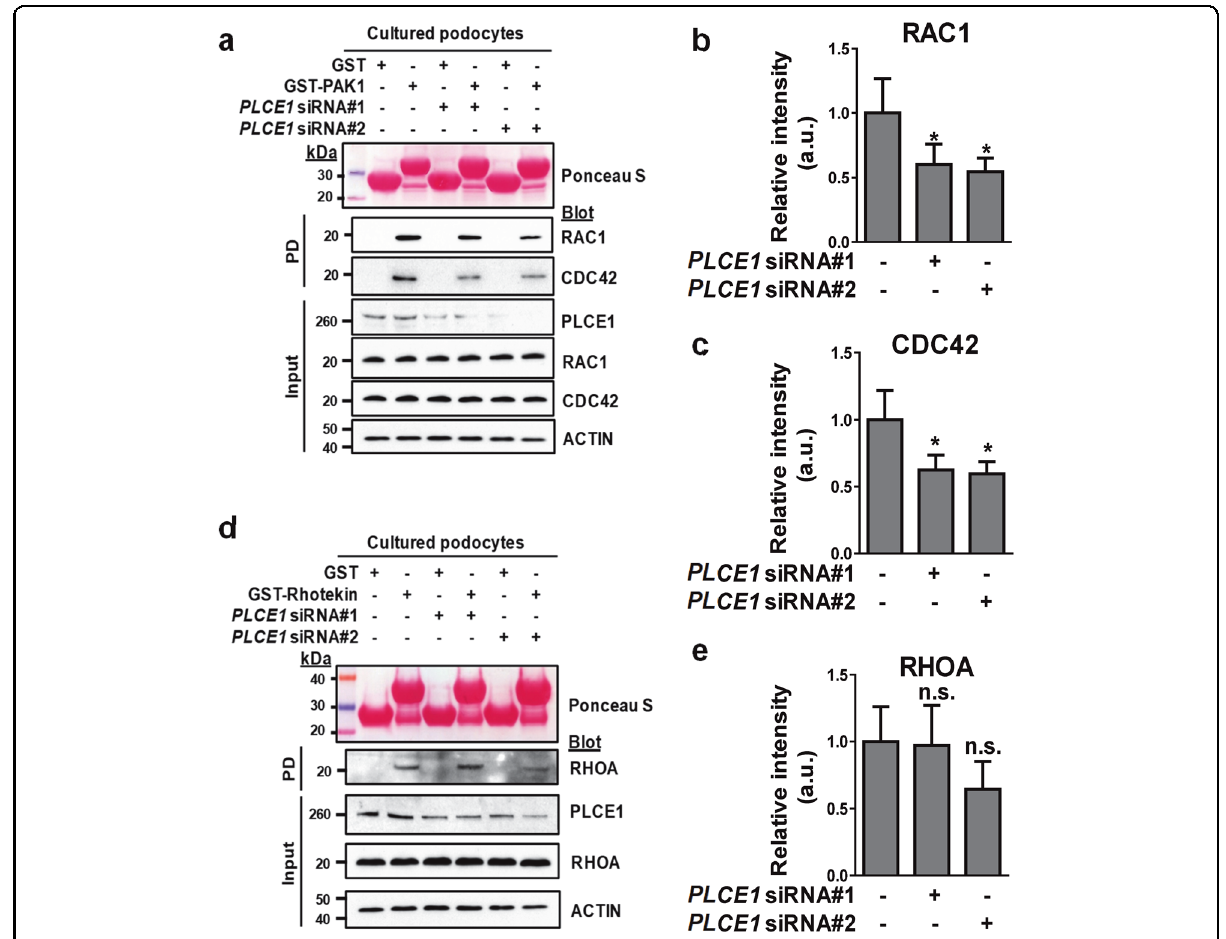
Fig. 3 The effects of the PLCE1 knockdown on Rho GTPase activity. a Active GTP-bound Rac1 and Cdc42 precipitated from podocytes transfected with PLCE1 siRNA using a GST-PAK1 (CRIB domain) pulldown assay. Ponceau red staining at the top shows the GST proteins used. Compared with control podocytes, podocytes transfected with PLCE1 siRNA exhibited a signi fi cant decrease in GTP-bound Rac1 and Cdc42 levels. b , c Quanti fi cation of Rac1 ( b ) and Cdc42 ( c ) in PLCE1 knockdown cells compared to that in control cells. d Active GTP-bound RhoA precipitated from podocytes transfected with PLCE1 siRNA using a GST-rhotekin (RBD domain) pulldown assay. Cells transfected with or without PLCE1 siRNA exhibited no signi fi cant differences in GTP-bound RhoA. e Quanti fi cation of RhoA in PLCE1 knockdown cells compared with that in control cells. Error bars indicate the standard deviations for more than three independent experiments. * P < 0.05; n.s. not signi fi